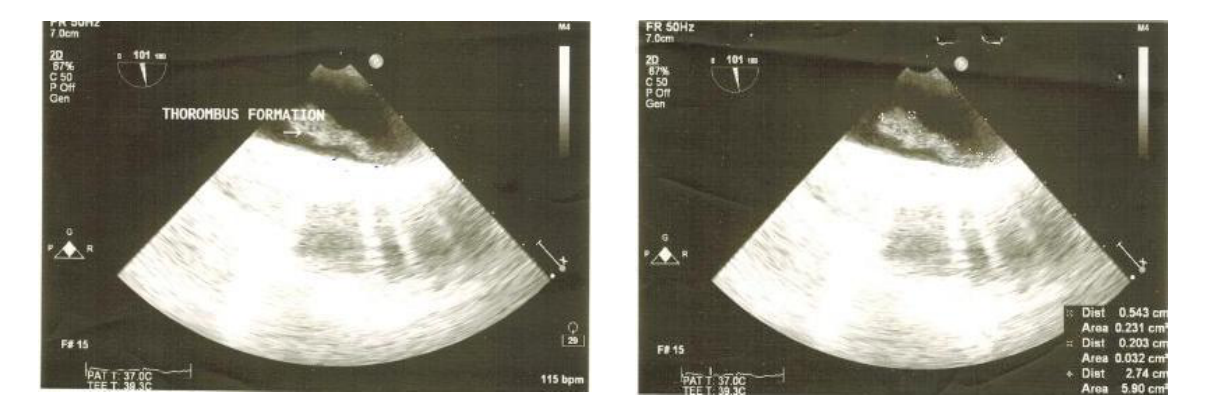
Figure 1. Presence of a mass lesion in proximal descending aorta, located in proximity of PDA and after the left subclavian artery Partial, as well as reversed symptoms of arm ischemia.